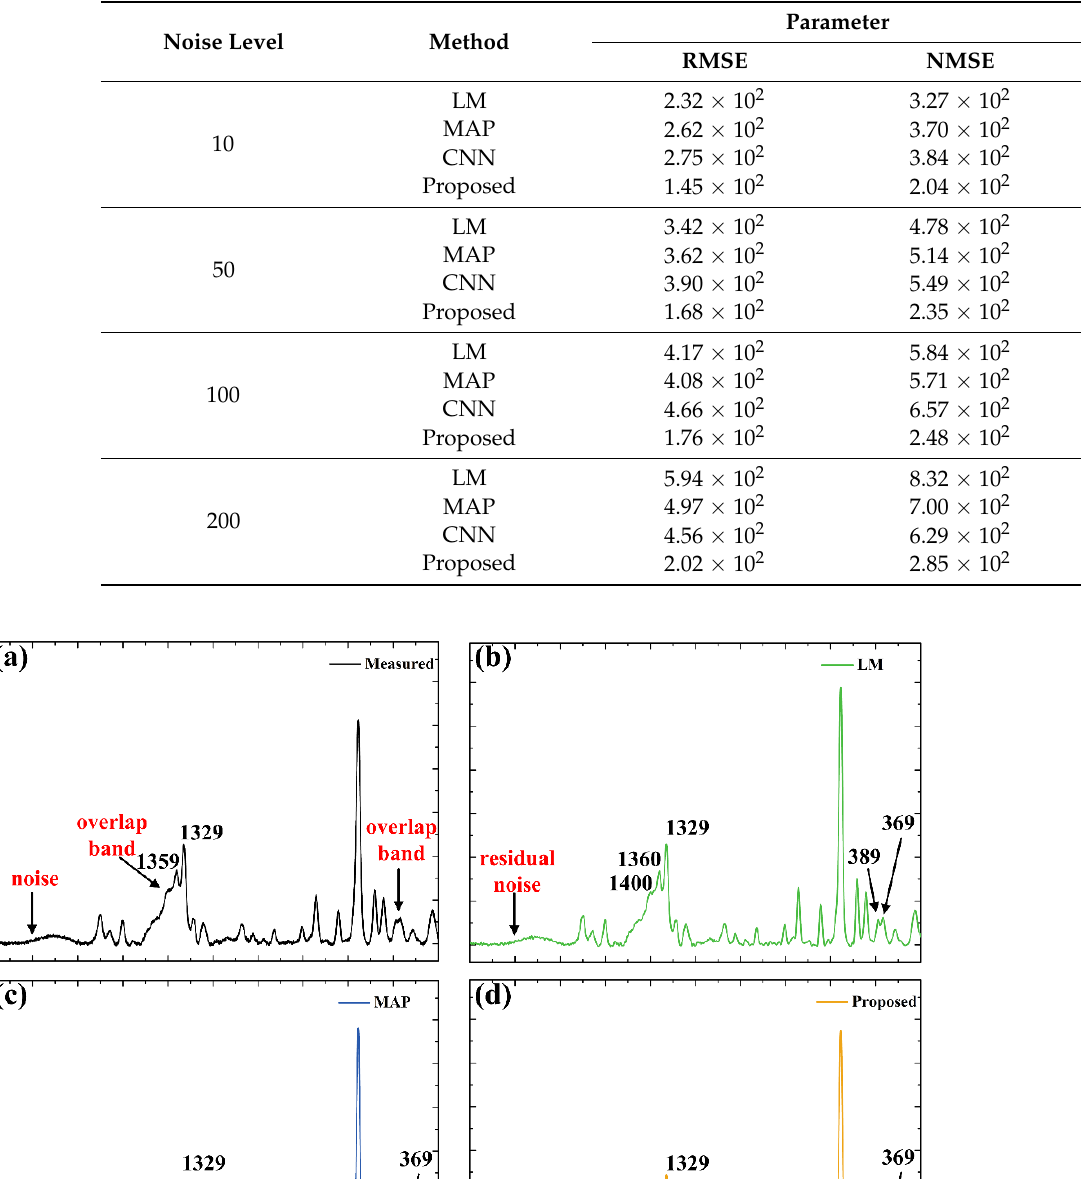
Table 3. RMSEs and NMSEs of the reconstruction results of measured Raman spectra with different noises by four methods.